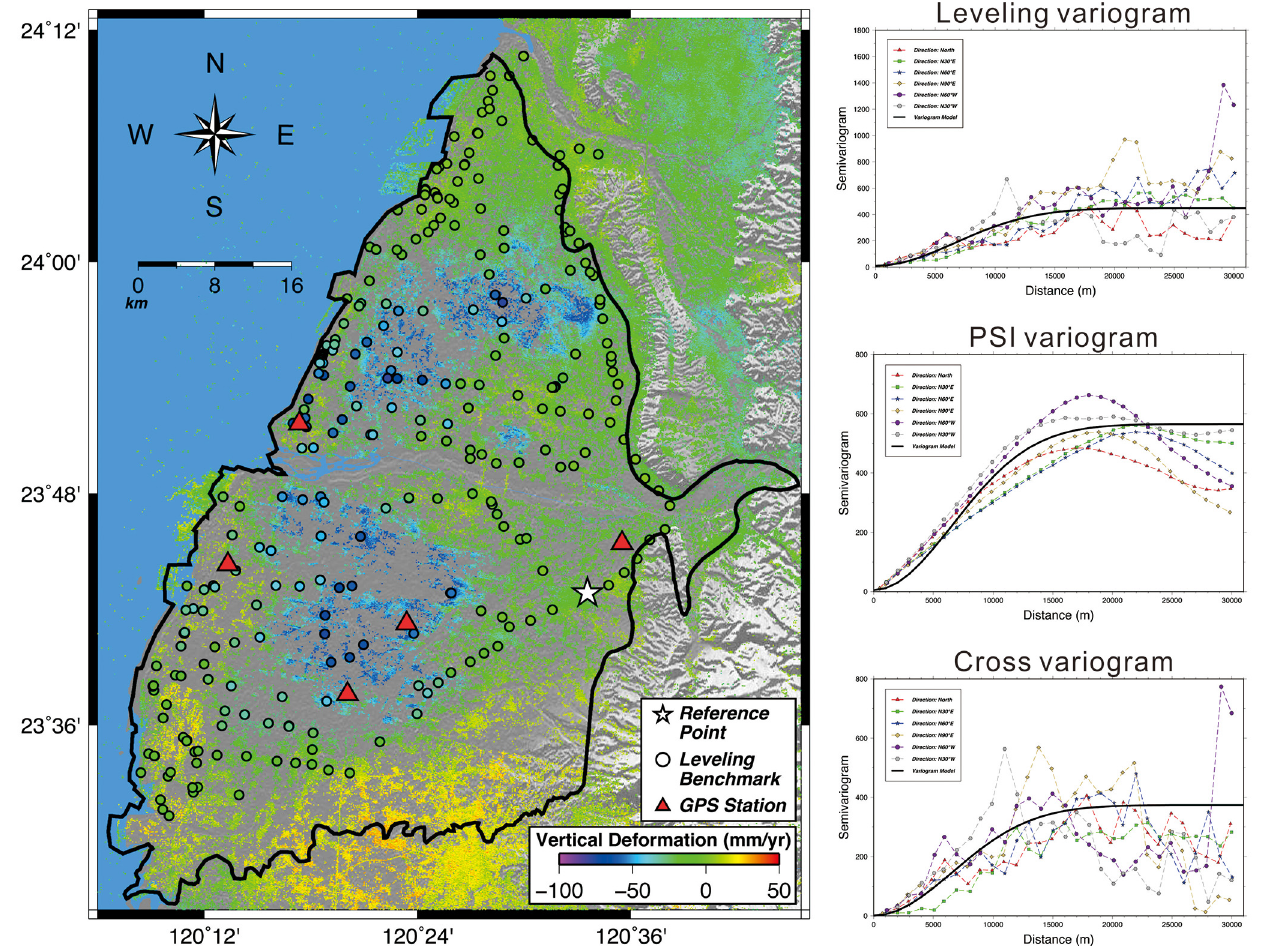
Figure 2. The left side of the figure is the vertical deformation of precise leveling and PSI between 2005 and 2008. The cold color means the land subsidence. The right side of the figure from top to bottom are precise leveling variogram, PSI variogram and cross-variogram between precise leveling and PSI. Every variogram has 6 directions and a Gaussian